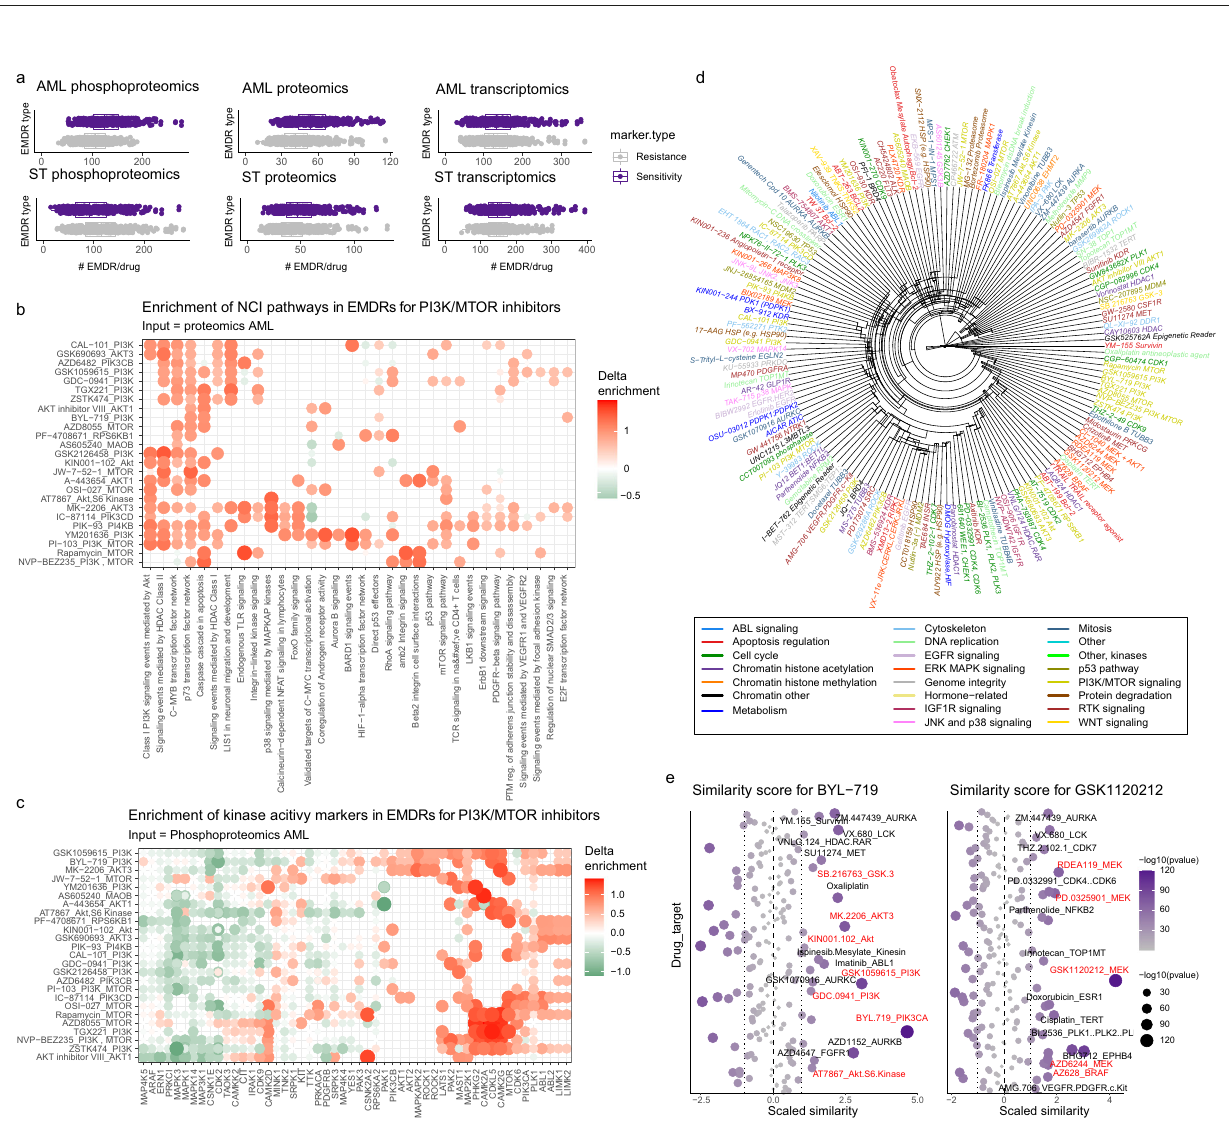
Fig. 2 Dimensionality reduction using empirical markers of drug responses. a Barchart of average AML cell line sensitivity to BYL-719 ( n = 19) rows are sorted in order of BYL-719 sensitivity (AAC). b Mean expression of top drug marker distance ( D ) values which correlate both positively and negatively with drug sensitivity to BYL-719 (2 tailed spearman correlation coef fi ecient) in AML omics datasets ( n = 19), measured in triplicate. Rows are sorted in order of BYL-719 sensitivity (AAC). Dot color intensities and sizes are proportional to distance values normalized 0 – 1. Rows in heatmap are ranked based on BYL- 719 sensitivity; columns are ordered based on hierarchical clustering (complete with Euclidean distance). c Overall correlation of each distance marker with BYL-719 sensitivity; red values correlate with sensitivity whilst blue values correlate with resistance. Dot sizes are proportional to Spearman rho value. Columns in heatmap are ordered based on hierarchical clustering (complete with Euclidean distance). d Comparison of measured vs predicted responses retuned by the eight different learning methods using phosphoproteomics data as input. Solid, dashed and dotted lines signify 0%, 10% and 20% absolute error boundaries, respectively. e As in ( d ) but D values were obtained from proteomics data. Learning algorithms were random forest (rf), cubist, bayesian estimation of generalized linear models (bglm), partial least squares (pls), principal component regression (pcr), support vector machine (svm), deep learning (dl) and neural network (nnet).